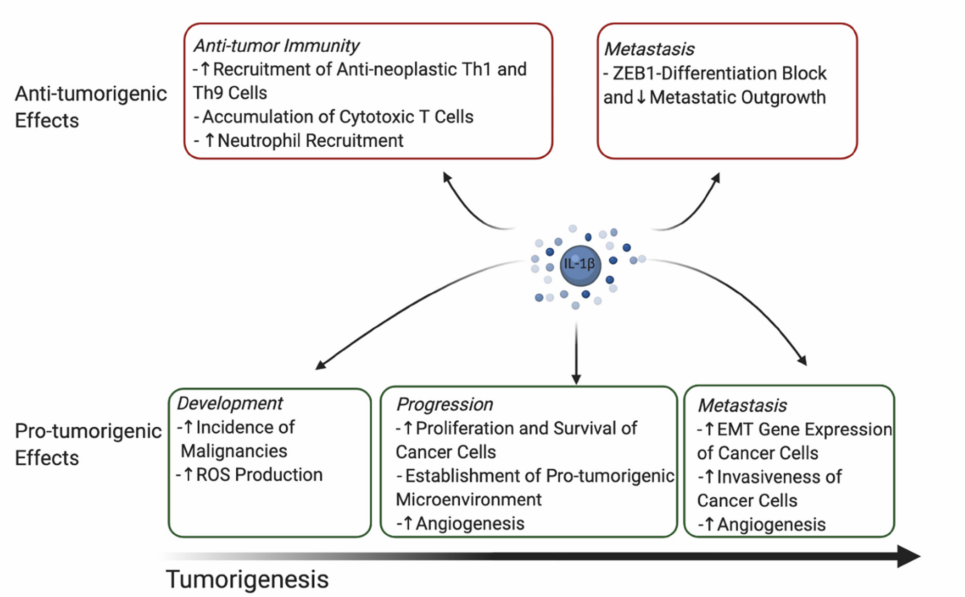
Figure 1. Overview of pro- and antineoplastic functions of IL-1 β . Th1/Th9, T helper 1/9 cells; ZEB1, zinc finger E-box-binding homeobox 1; ROS, reactive oxygen species; EMT, epithelial– mesenchymal